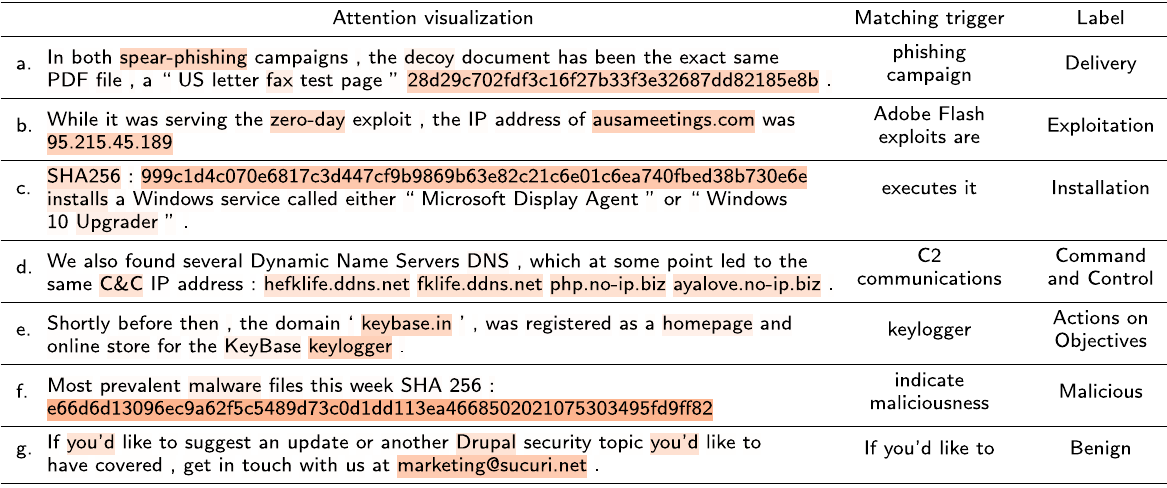
Table 4 Case study 2. Attention Distribution Exploration. Darker cell color, meaning higher attention weight, demonstrates that the triggers contribute to the classification